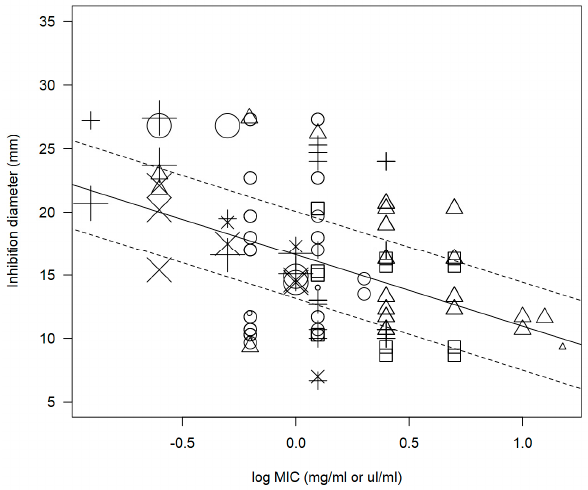
Figure 1. Scatter plot depicting the effect of the logarithm of the MIC (log MIC) of Origanum ( n = 145), Syzygium aromaticum ( n = 10), and Citrus ( n = 7) extracts on inhibition diameters for each bacterium. Markers symbolise the following: □ = C. jejuni , ○ = L. monocytogenes , ∆ = S. aureus , + = Salmonella , × = STEC. The size of each marker corresponds to the sample size, with larger markers representing larger study populations.